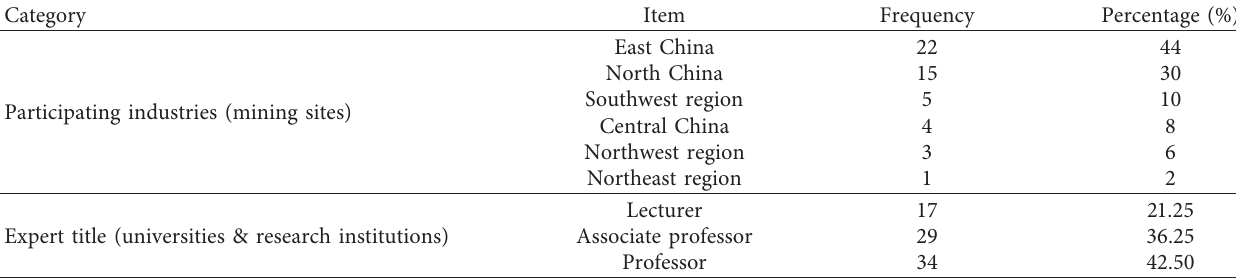
Table 2: Basic information of participants.